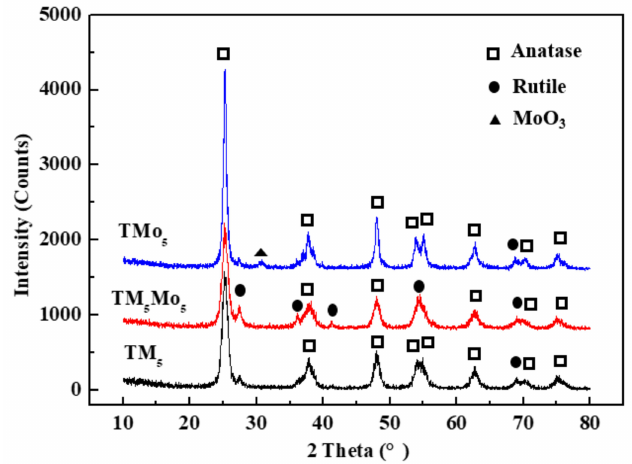
Figure 3. The X-ray powder di ff raction (XRD) results of the three